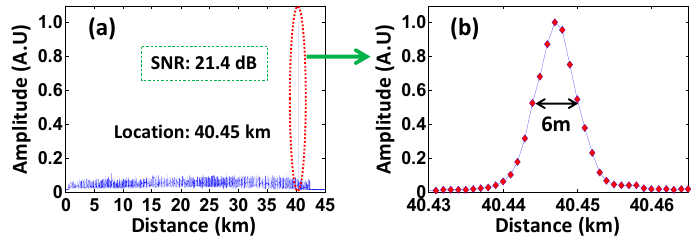
Figure 5. ( a ) The location and SNR of the vibration; ( b ) the achieved spatial resolution of this system. Restricted by the fiber length of 42.5 km, the pulse repetition of 2 kHz was used in the